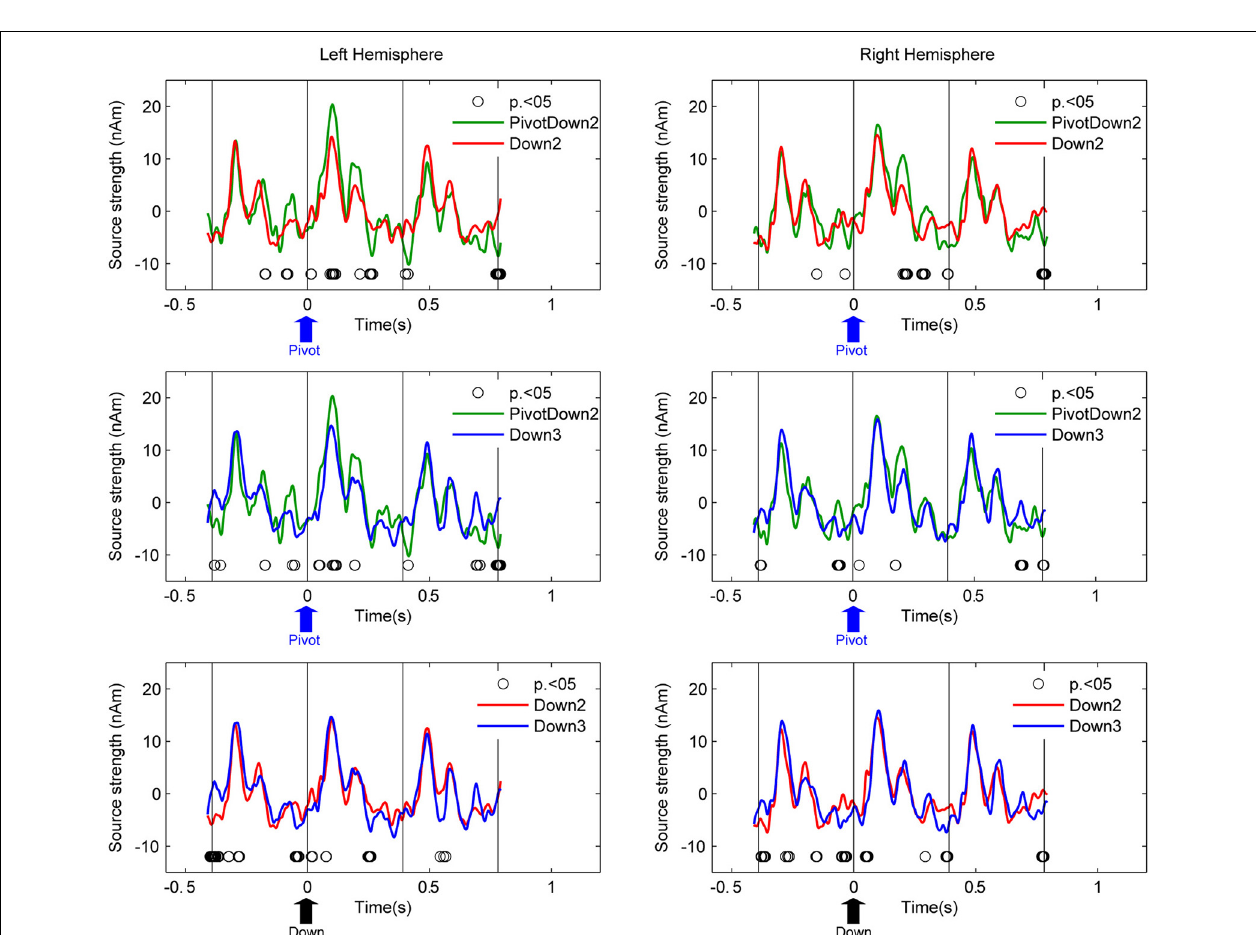
the MEG sensors (top-view). The right panel shows magnetic field topography for each condition at the latency of 98.1ms, and the difference (PivotDown2-Down2).